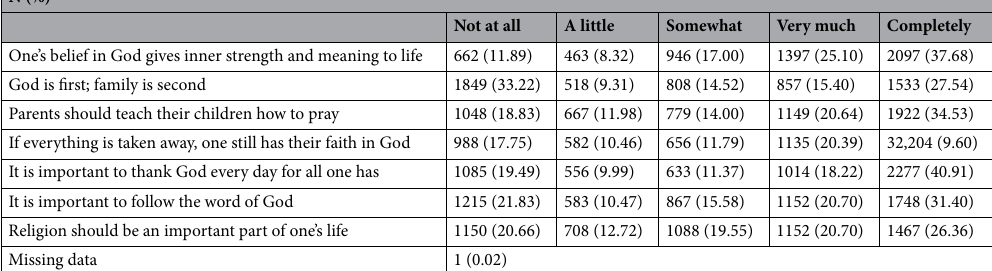
Mexican American Cultural Values Scale (MACV): Religious beliefs N (%)